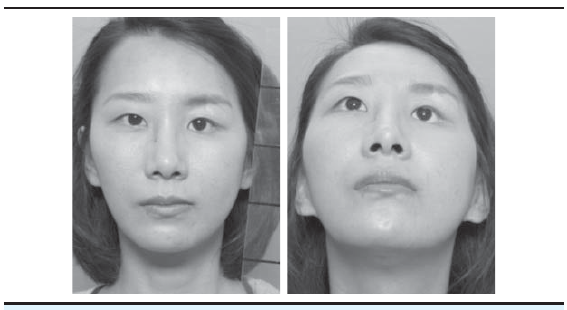
Figure 1. Preoperative frontal (left) and low basal view (right) Frontal and low basal views show marked dystopia and enophthalmos in the left side